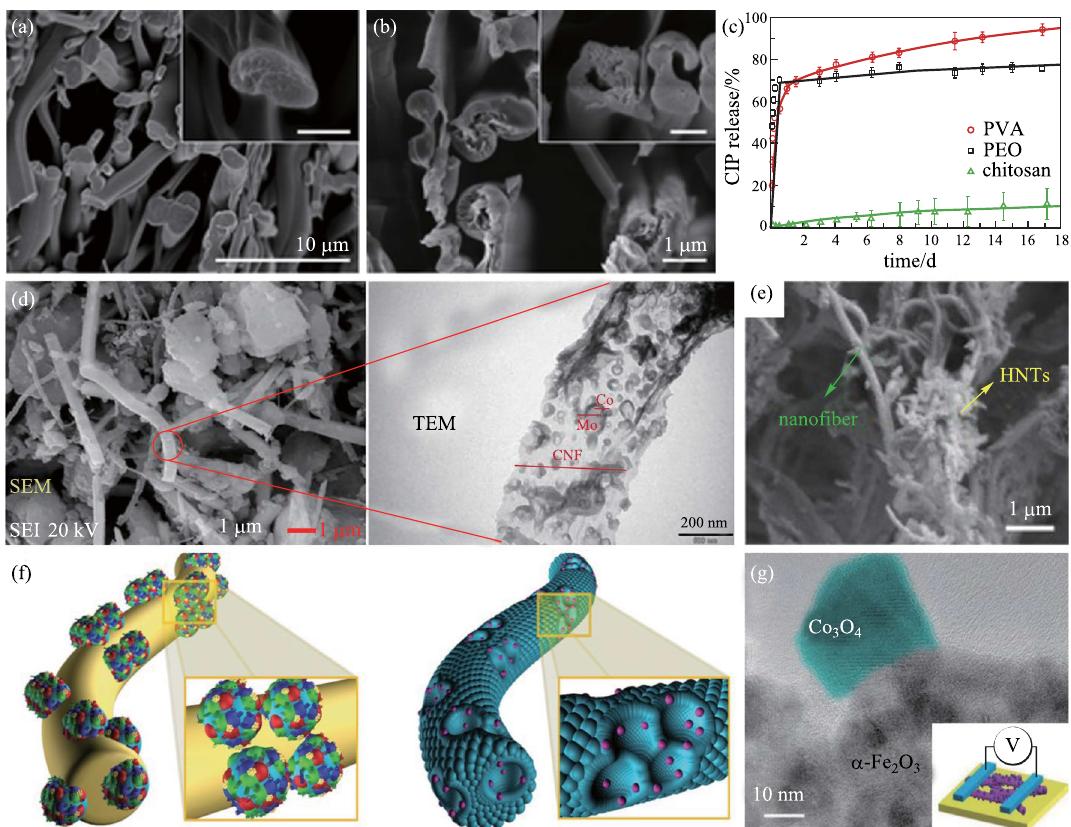
Fig. 4 a , b SEM images of nanofiber cross sections before a and after drug release for 18 days b . c Release profiles of CIP from blended nanofibers with 10 wt % of PVA, PEO, or chitosan added to PMMA [81]. d SEM image and TEM image of AlCNF and MoCo catalyst on the nanofiber [86]. e SEM image of HNTs on PI nanofiber [87]. f Schematic illustrations of as-spun composite nanofiber comprising W precursor, PVP, and catalyst-decorated PS colloids (the left picture) and catalytic nanopartical-loaded porous WO 3 nanofibers after calcination (the right picture) [88]. g TEM image of hetero-nanofiber with Co 3 O 4 and α-Fe 2 O 3 crystal phases. Inset: schematic of a device for electrical